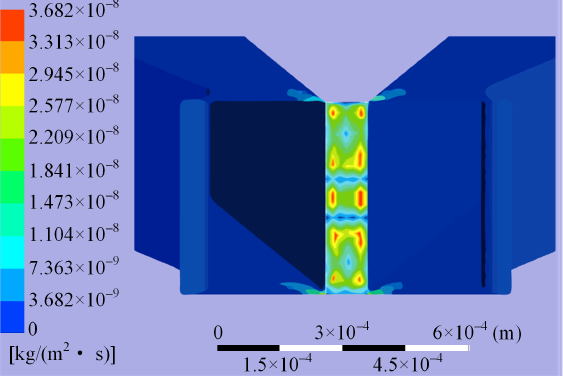
Figure 8. Erosion rates on shunt wedge.